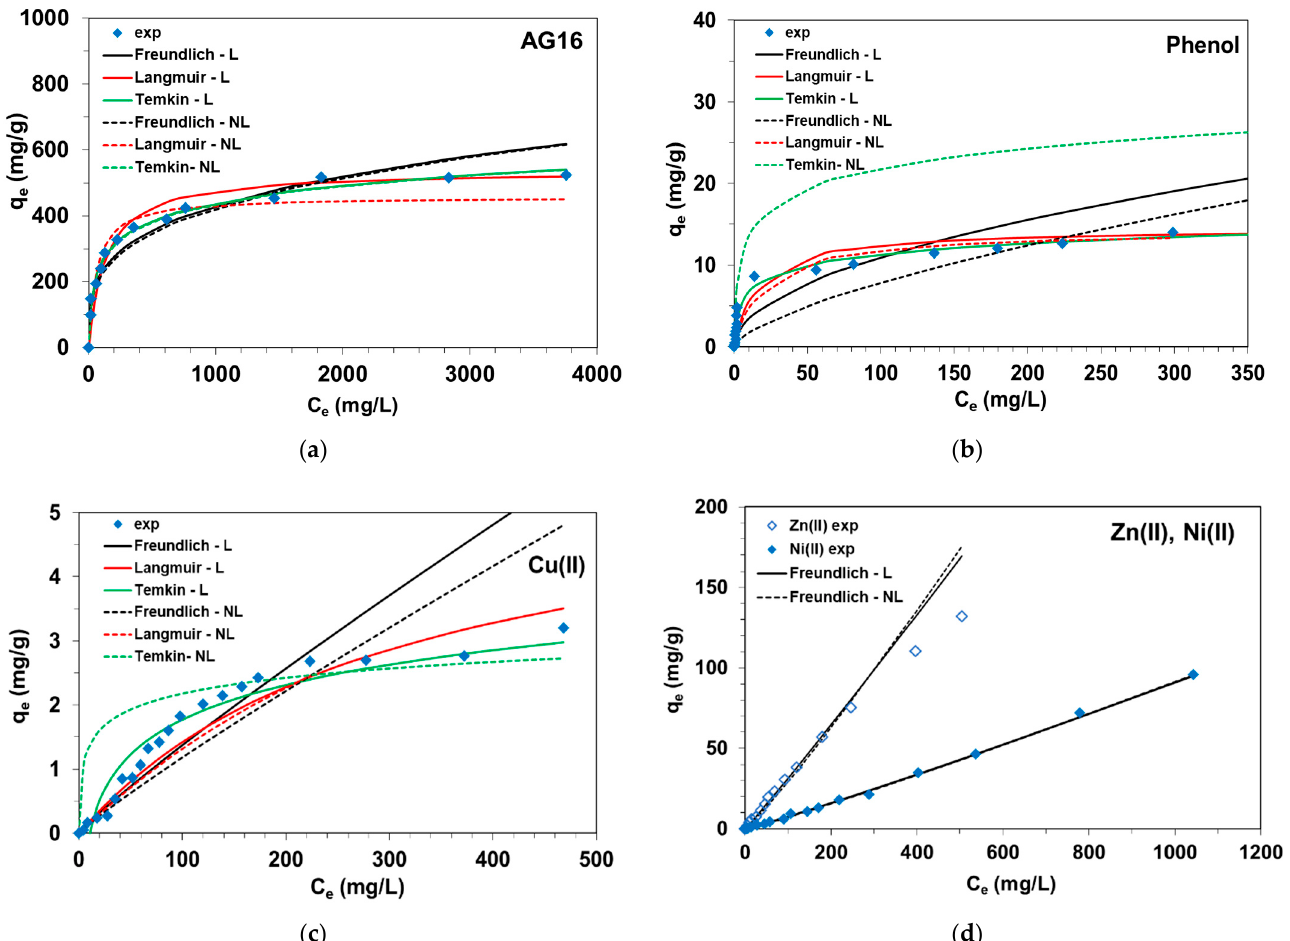
Figure 2. Isotherm experimental data of ( a ) AG16, ( b ) phenol, ( c ) Cu(II), ( d ) Zn(II) and (Ni) on S5528 anion exchange resin corresponding with fitting curves to the Freundlich, Langmuir and Temkin isotherm equations using linear (L) and non-linear (NL) regression.